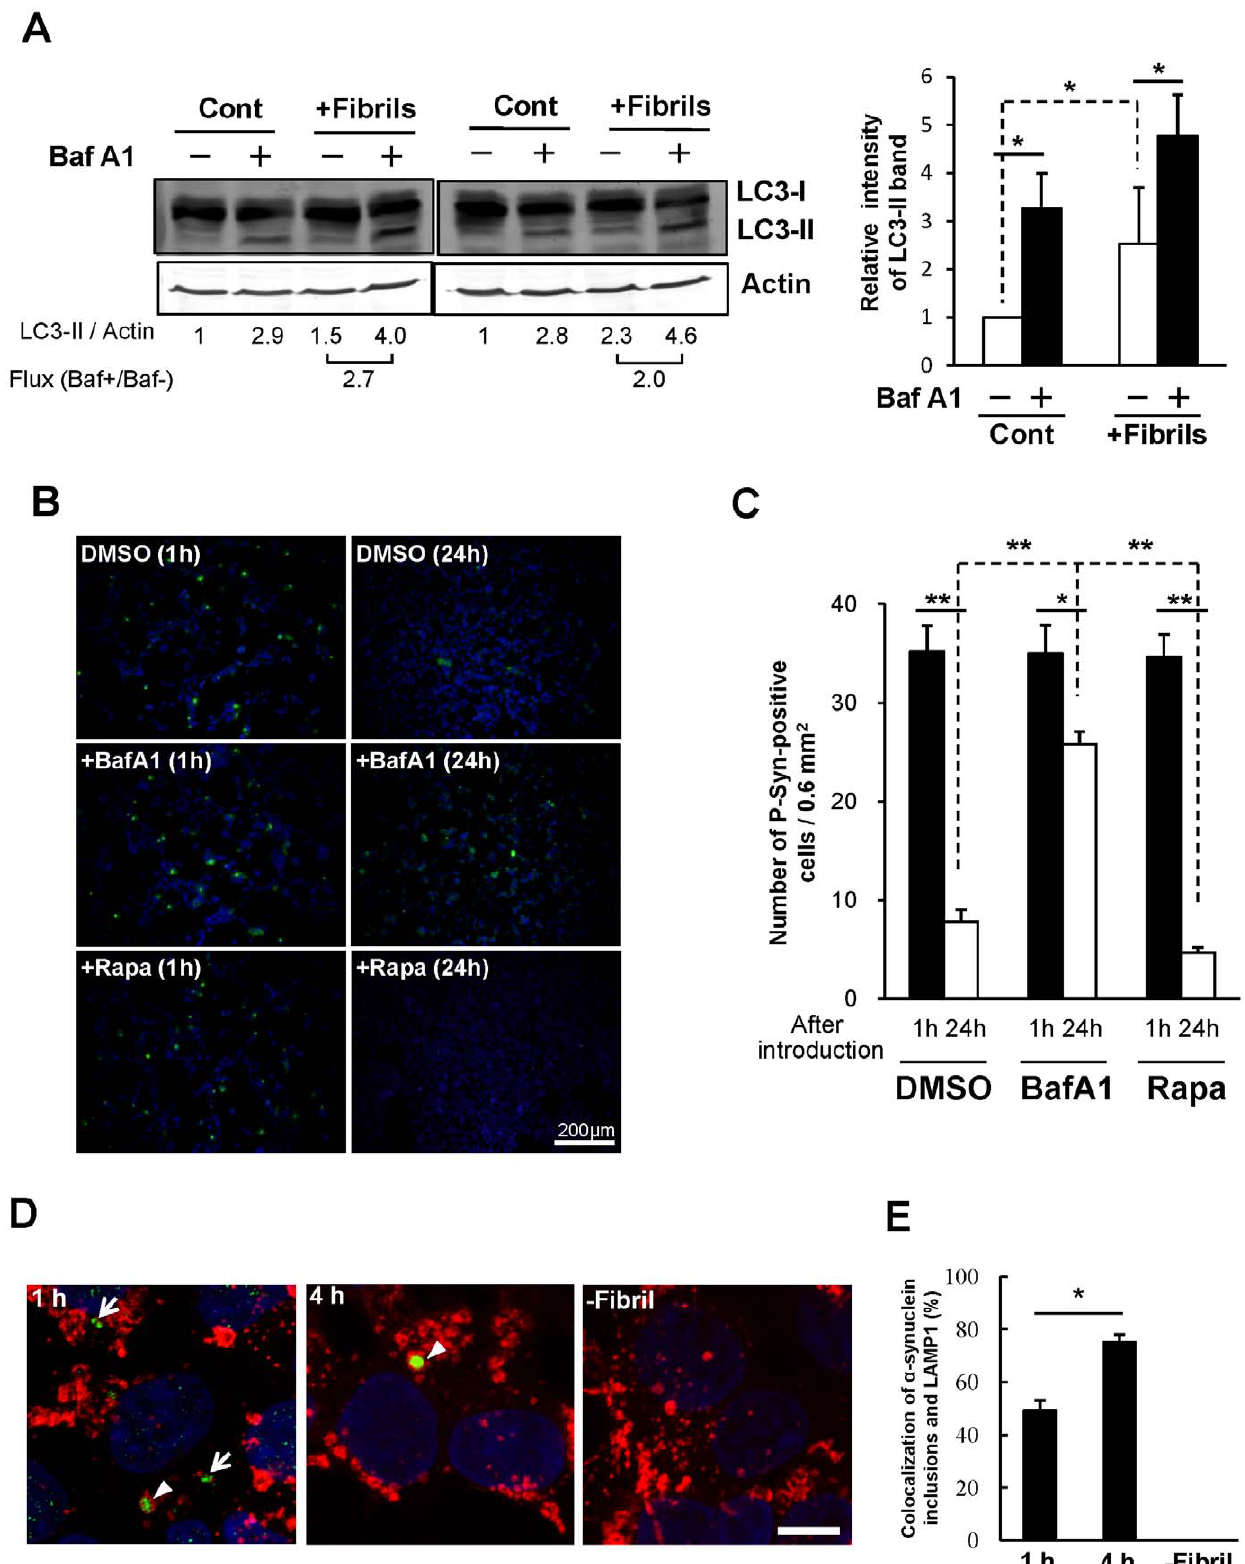
Figure 4. Autophagic clearance of a -synuclein inclusions. ( A ) Autophagy flux was analyzed by LC3 protein monitoring. a -Synuclein fibrils- introduced HEK293 cells were treated with ( + )/without ( 2 ) bafilomycin A1 (BafA1) for 2 h. Cell lysates were subjected to immunoblotting analysis using anti-LC3 (upper panel) or anti-actin (lower panel) antibodies. Quantification of the relative levels of LC3-II/Actin or autophagic flux (Baf + /Baf-) is